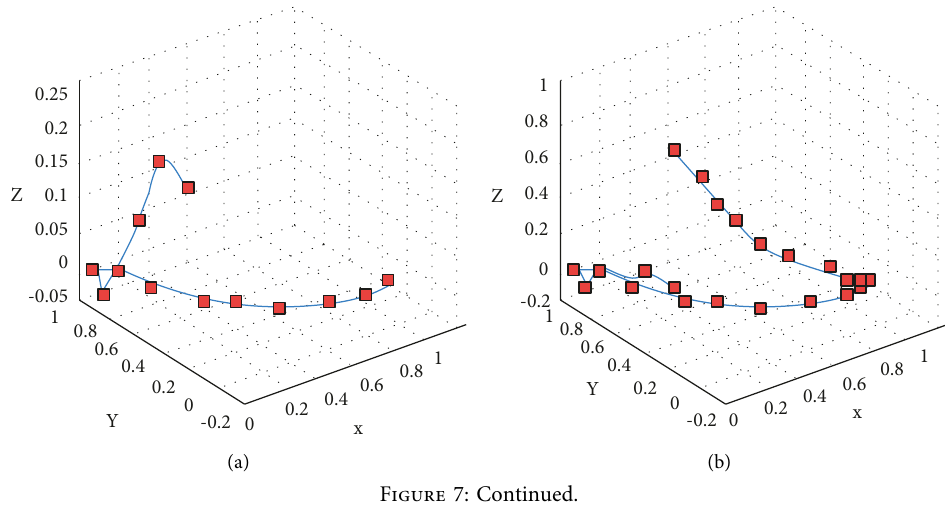
-0.0500.050.10.150.20.25